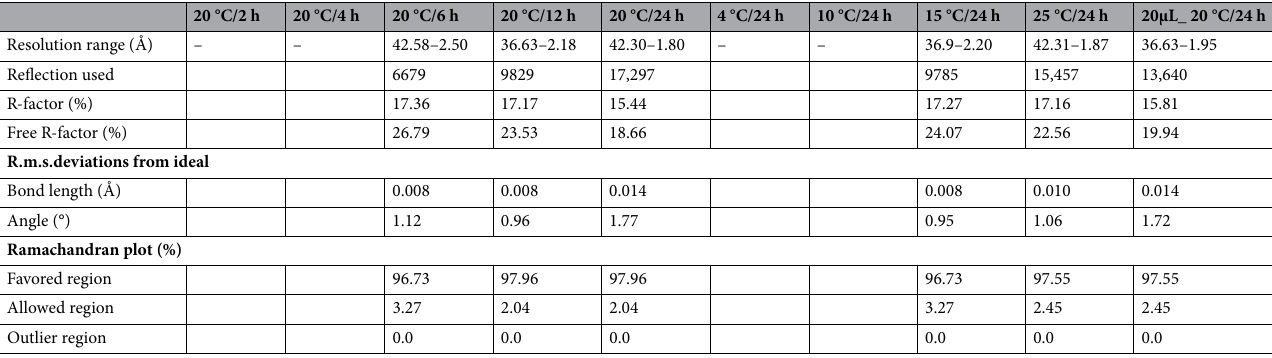
Table 3. Refinement statics of PhC_CF .